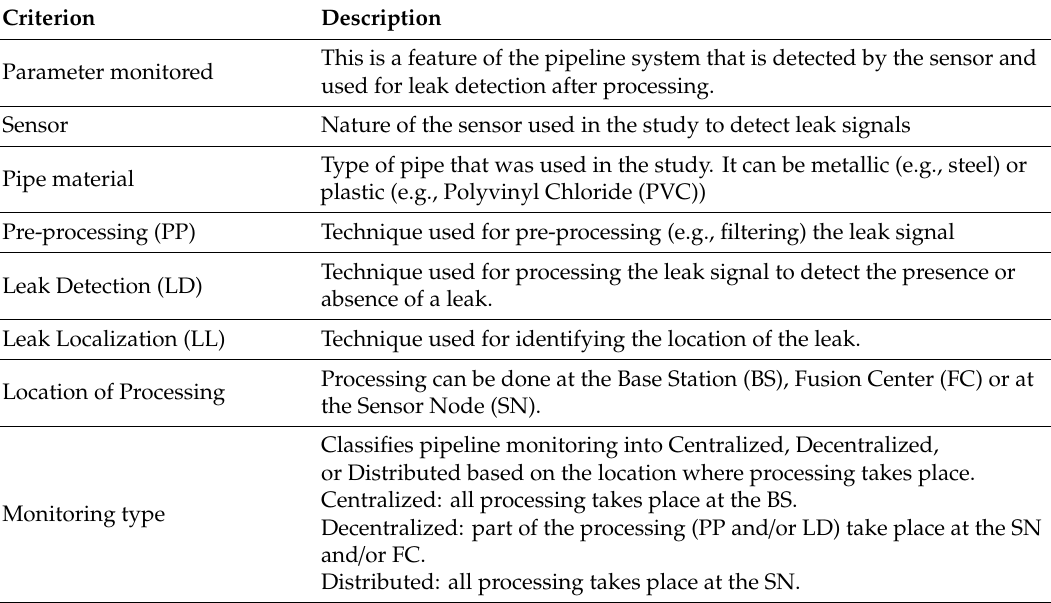
Table 1. List of criteria for comparing selected